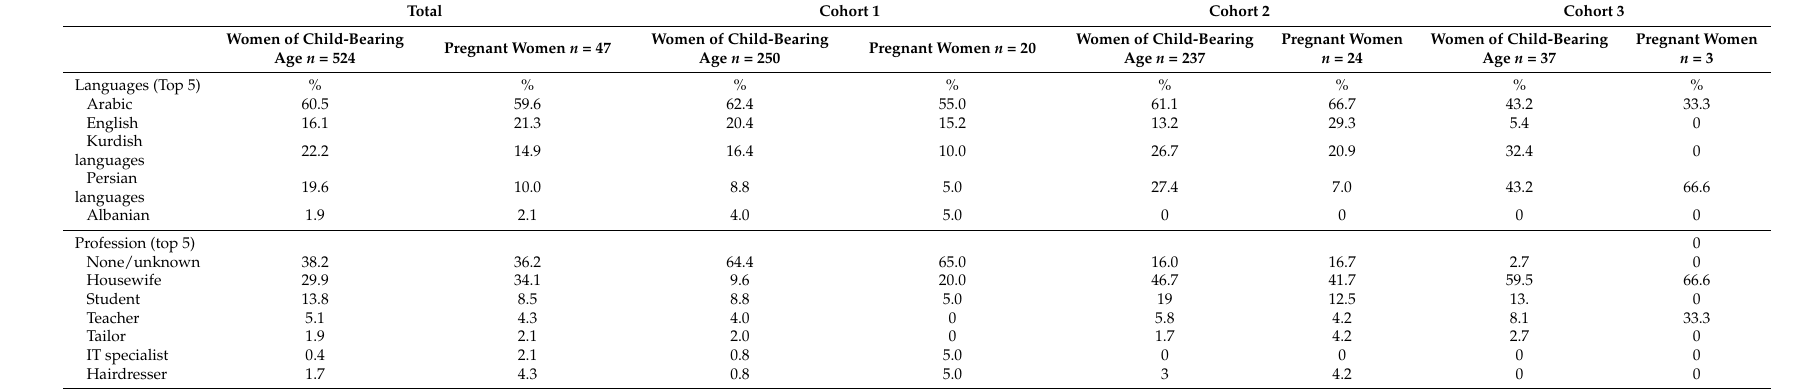
Table 2. Cohort-specific characteristics of women of childbearing age and pregnant refugees, language skills and profession. Total Cohort 1 Cohort 2 Cohort 3 Women of Child-Bearing Women of Child-Bearing Age n = 250 Pregnant Women n = 20 Age n = 524 Pregnant Women n = 47